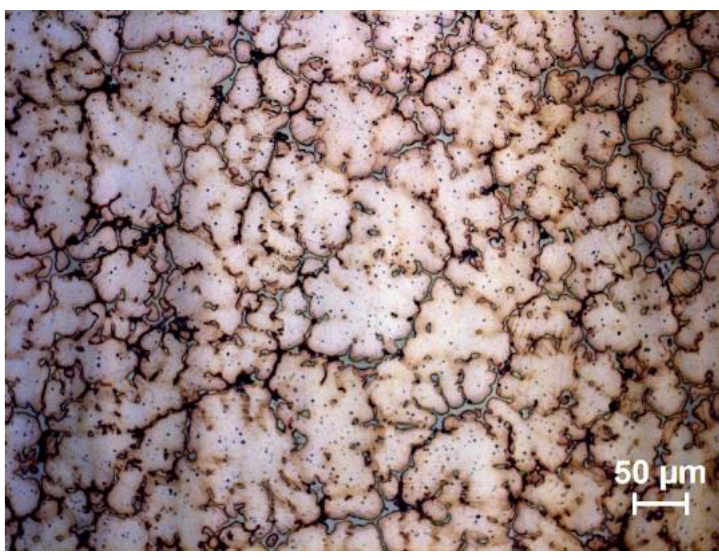
Figure 3. The microstructure of quenched Mg-1Mn-4Zn alloying systems at 200×.